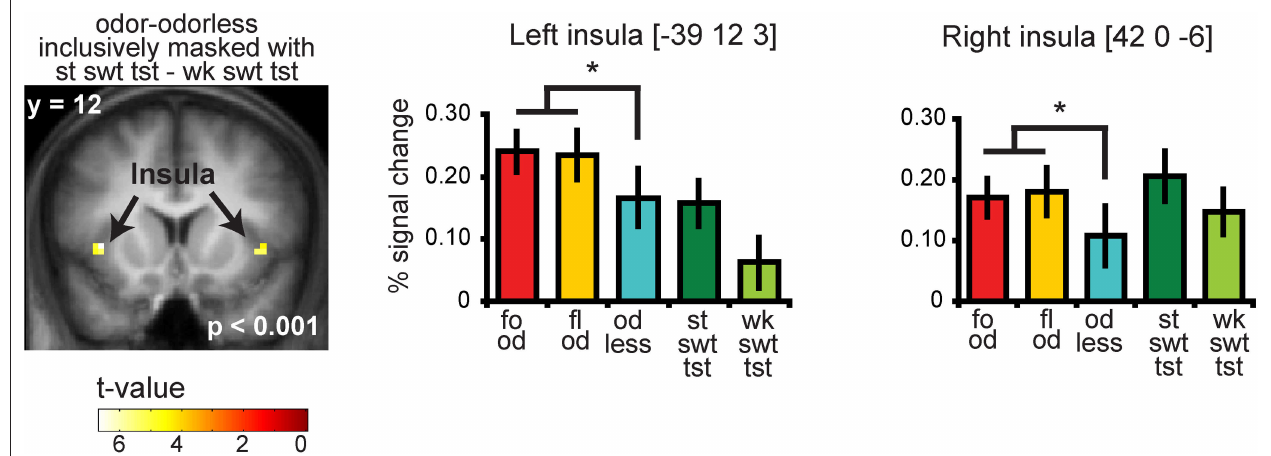
FIguRe 5 | Coronal section showing neural response to food and floral odors vs. odorless air in bilateral insula, inclusively masked by response to strong sweet taste minus weak sweet taste. The bar graphs show the percent signal change for the three odor conditions: food (red), floral (yellow), and odorless air (blue), and the two taste conditions: strong sweet taste